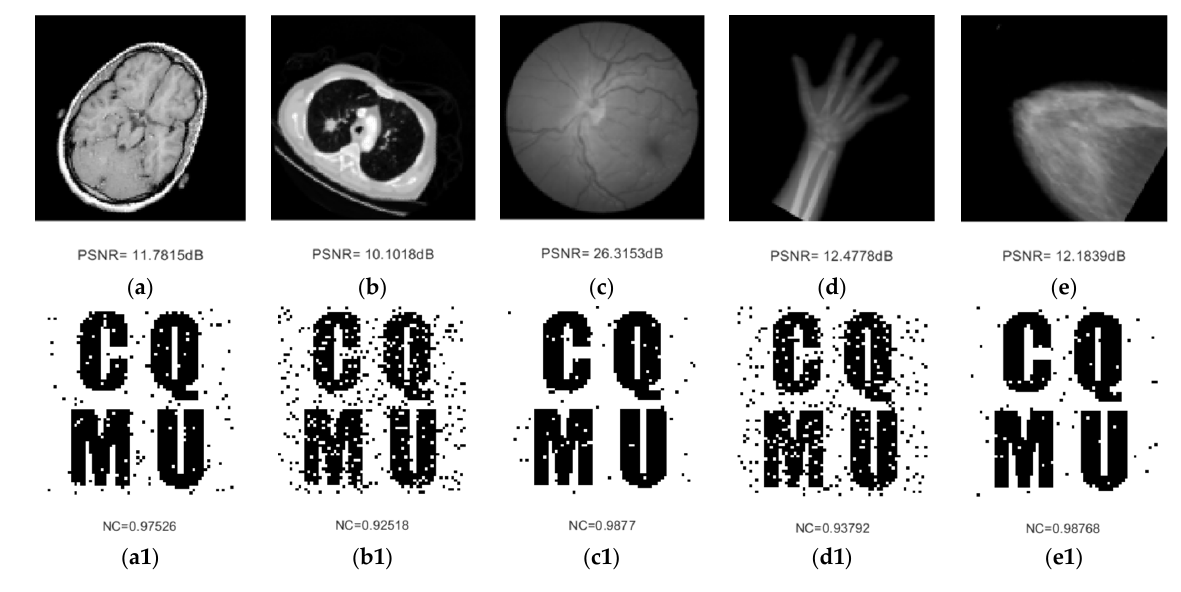
Figure 12. Attacked medical images and restored watermarking images under clockwise rotation 30°: ( a , a1 ) brain and extracted watermarking image; ( b , b1 ) chest and extracted watermarking image; ( c , c1 ) fundus blood vessels and extracted watermarking image; ( d , d1 ) hand and extracted water- marking image; and ( e , e1 ) breast and extracted watermarking image. Table 4. The result under clockwise rotation attacks.